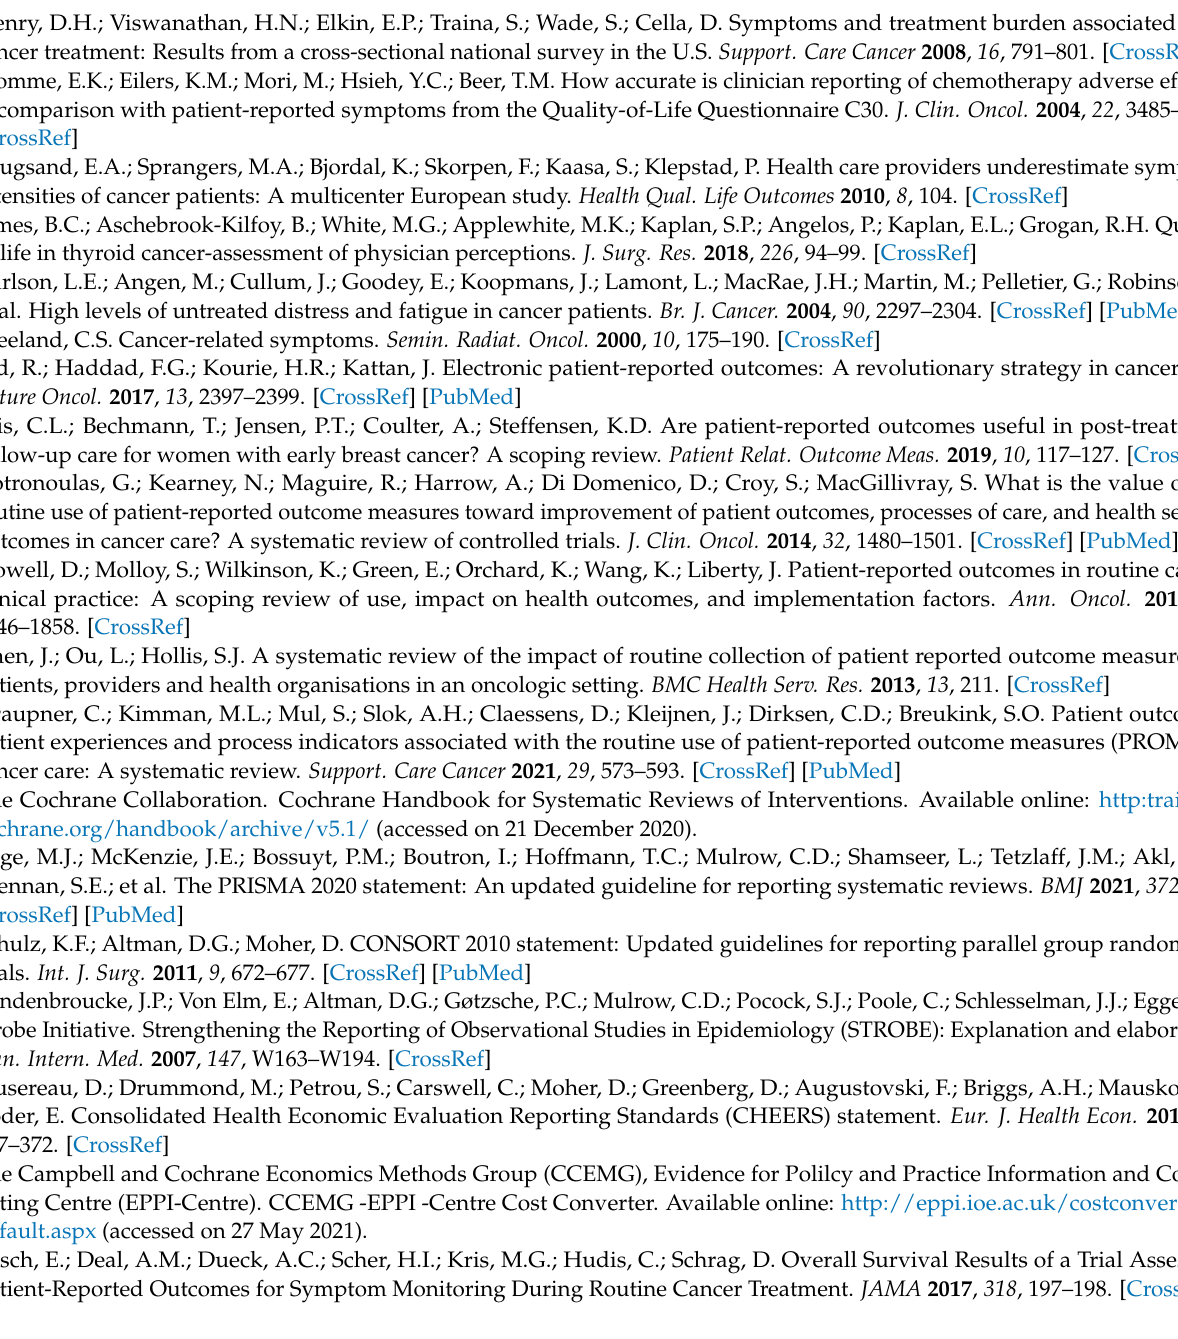
Table S3: Comprehensive list of search terms considered, Table S4: Search strategy, Table S5: Ex- cluded